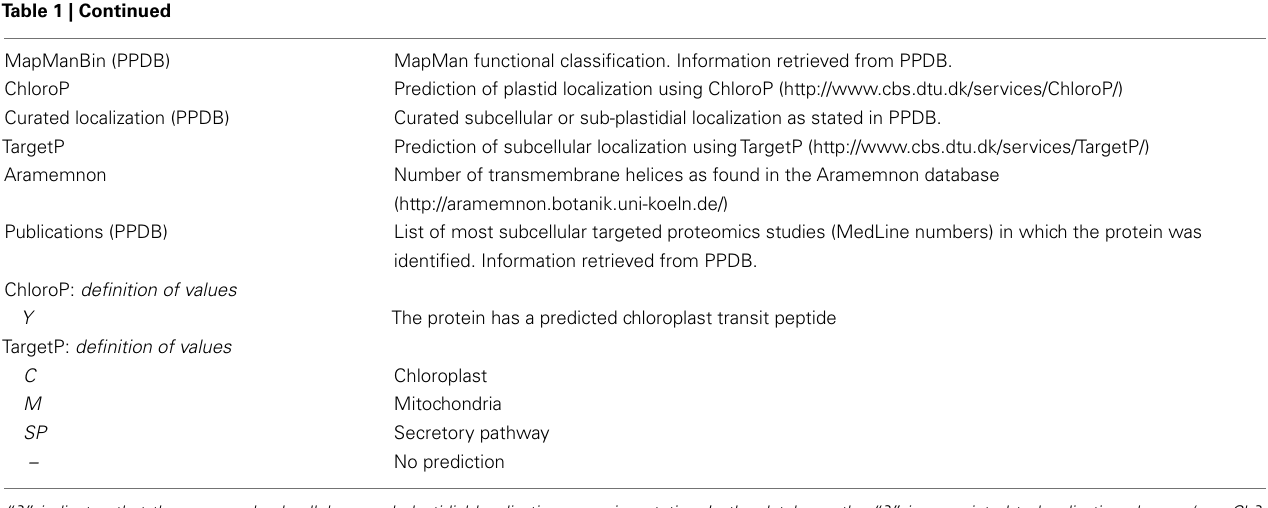
MapMan functional classification. Information retrieved from